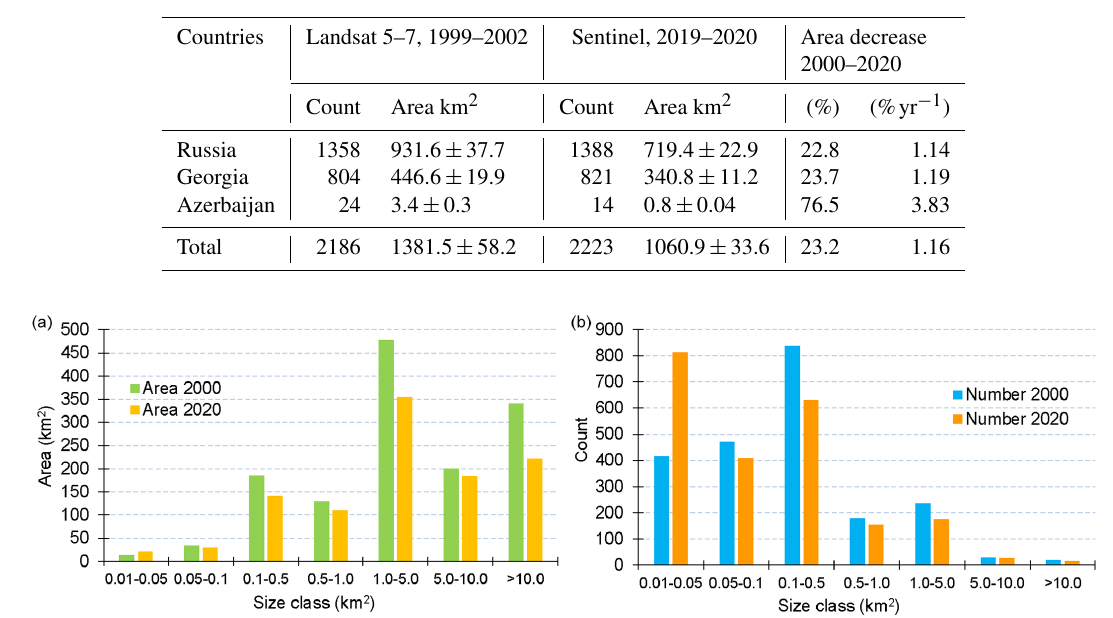
Figure 4. Relative frequency histograms for (a) glacier area and (b) count for the seven glacier size classes in the Greater Caucasus in 2000 and